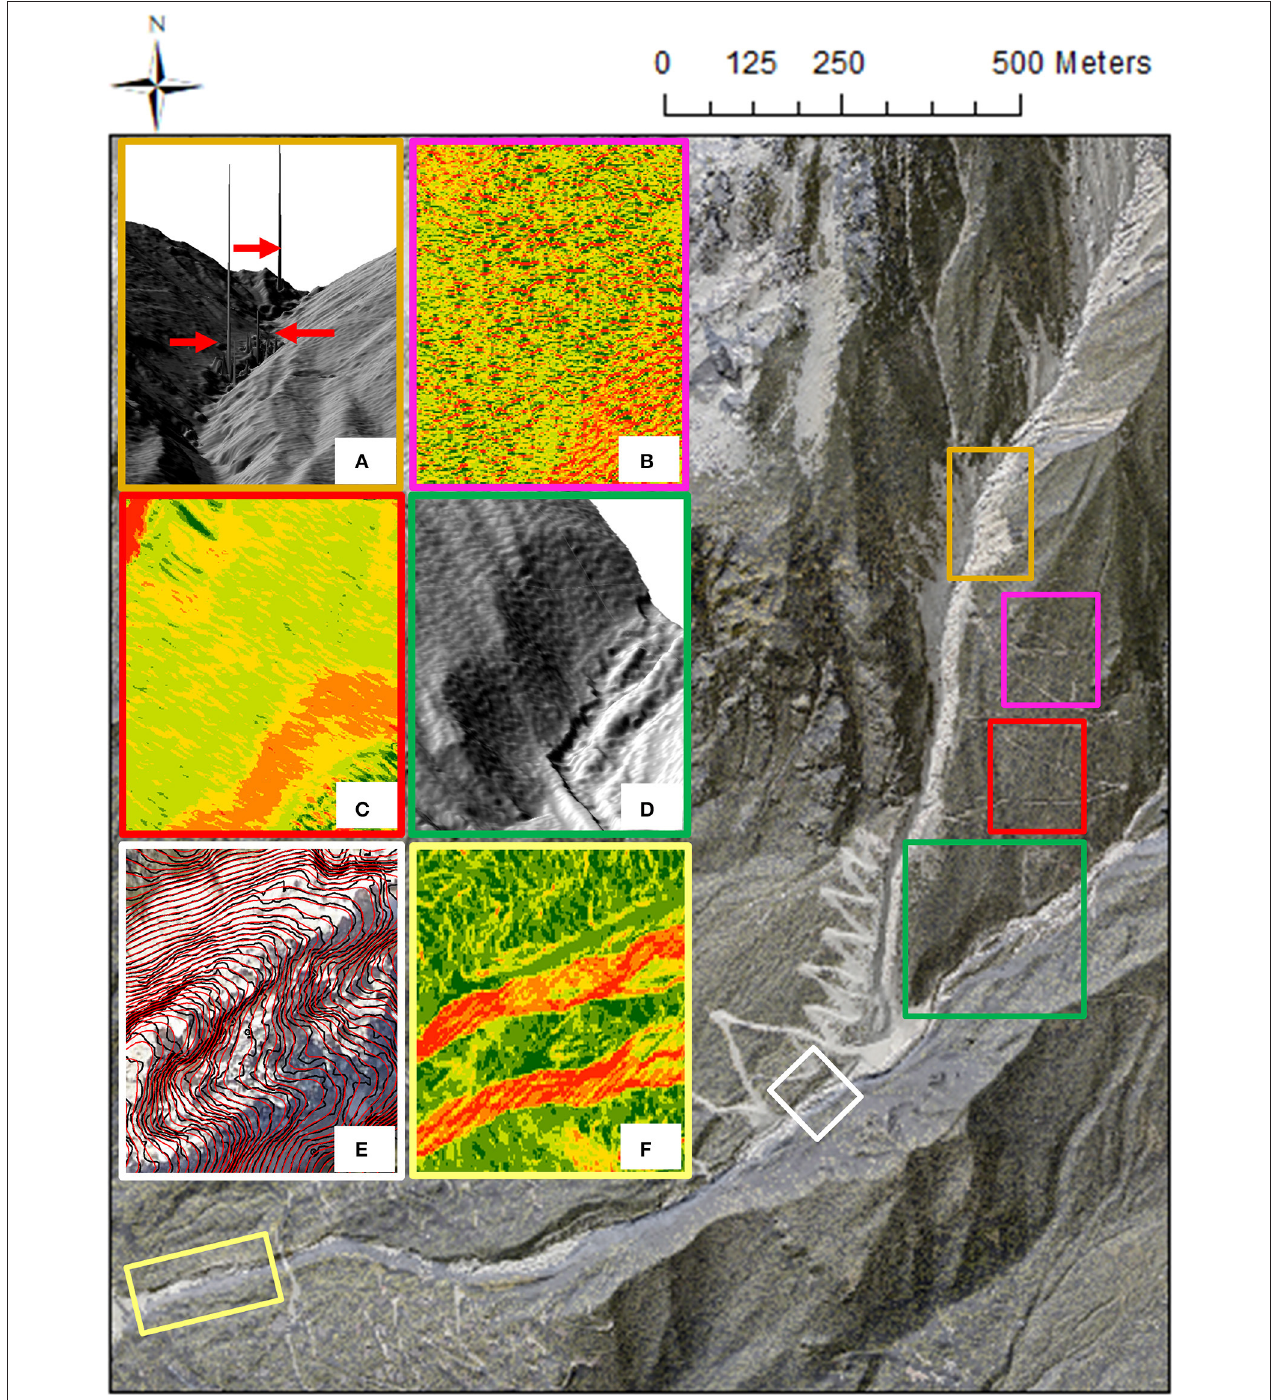
FIGURE 8 | Overview of the detected interpolation artifacts: (A) spiky features in the upper part of the debris flow channel due to function under- and over-shooting in correspondence of slope discontinuities, (B) noisy relief with a discontinuos spatial pattern of slopes, (C) striping effect oriented according to the direction of variogram modeling, (D) undulating surface, (E) over-smoothed surface (red lines: 1-meter interval contour lines of the ANUDEM-derived DEM, black lines: 1-meter interval contour lines of the natural neighbor-derived DEM), (F) striping effect oriented according to the sampling direction.